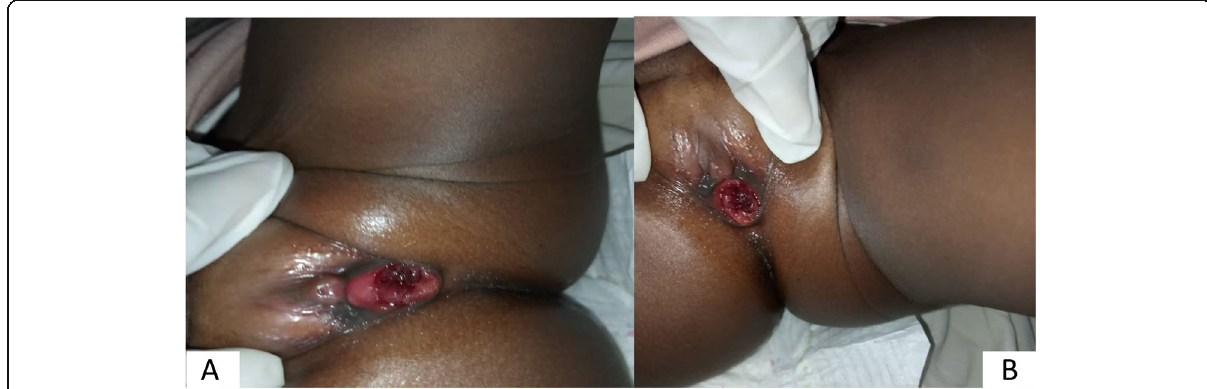
Fig. 1 a Picture of uterovaginal prolapse in transverse view. b Picture of uterovaginal prolapse in longitudinal